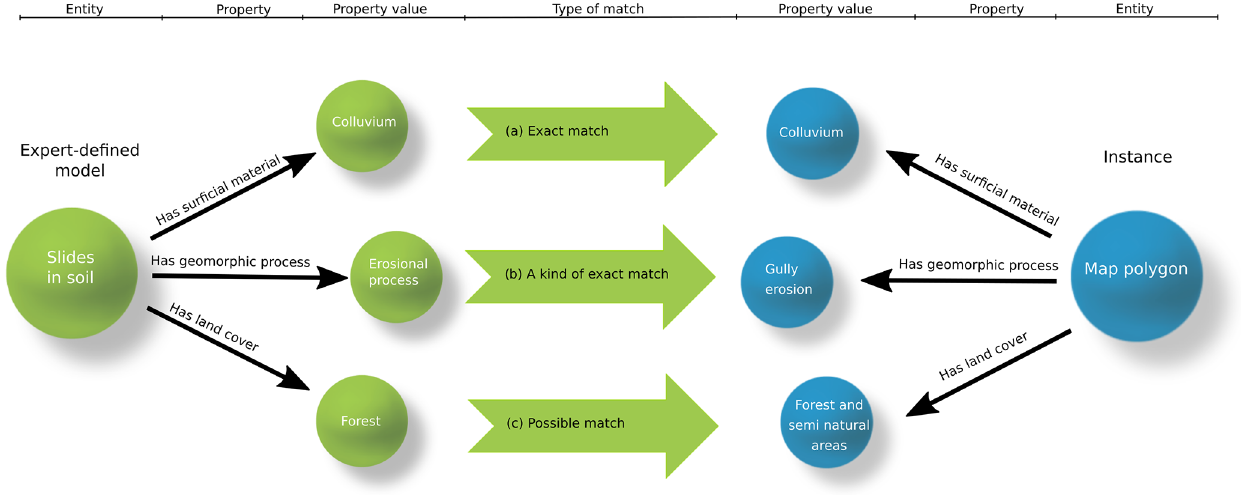
Figure 2. Graphical representation of the matching process between expert-defined models and map polygon instances. Panel (a) is an example of an exact match between the property value “colluvium”; (b) is an example of a kind of (AKO) exact match because “gully erosion” is a more specific kind of “erosional process”. The model is looking for an “erosional process” and found a “gully erosion”; (c) is an example of a possible exact match because “forest and semi-natural areas” is a broader concept of “forest”. The model is looking for “forest”, but we do not know whether the instance is a “forest”. We only know that the instance is “forest and semi-natural areas”. The vocabulary and the hierarchy are controlled by the ontology. Note that frequency terms for model properties are not shown in this